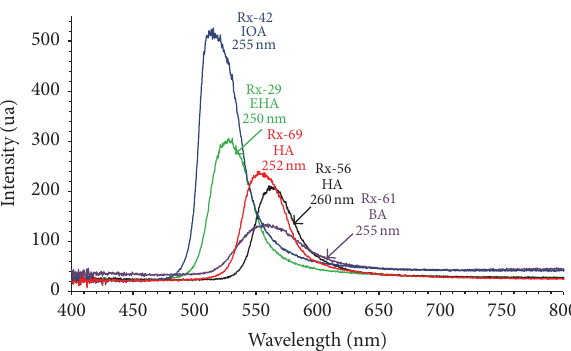
Figure 4: SEM micrograph of synthetized microspheres containing 39% molar amount of IOA (Rx-66, entry 4 of Table 1). Figure 5: Reflectance spectra of the films made with microspheres with similar sizes. The spectra were measured at normal incidence. Sizes of microspheres were evaluated by